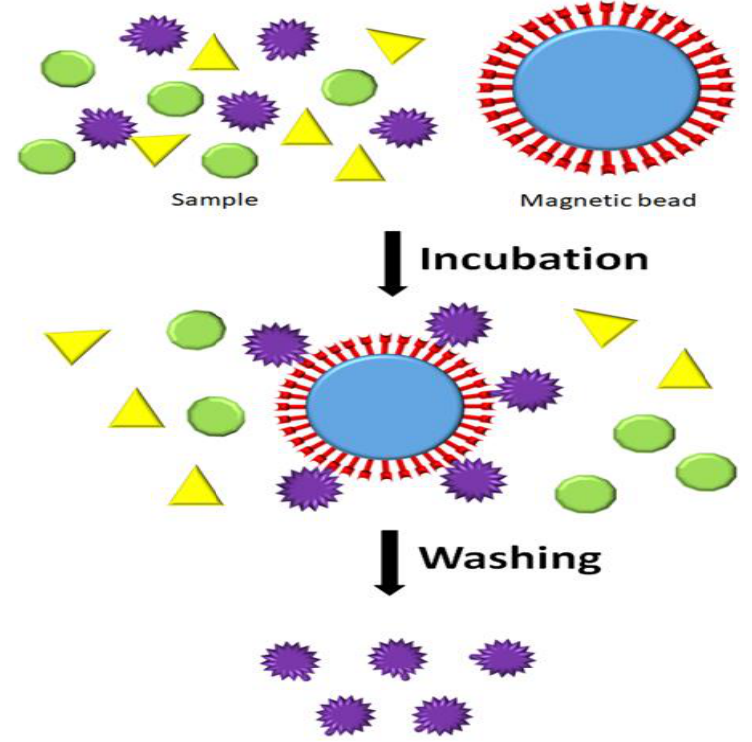
Figure 6. The principle of magnetic separation techniques.